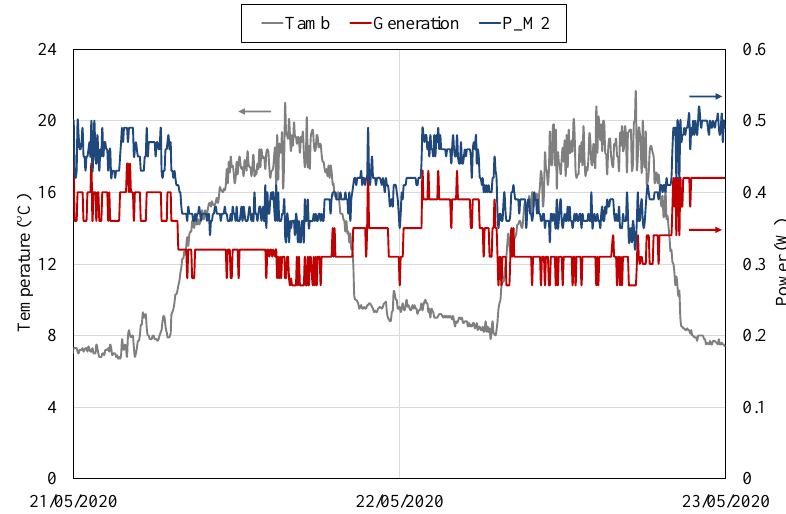
Figure 13. Ambient temperature T amb (left axis), power generated by M2 and total generation (right axis)